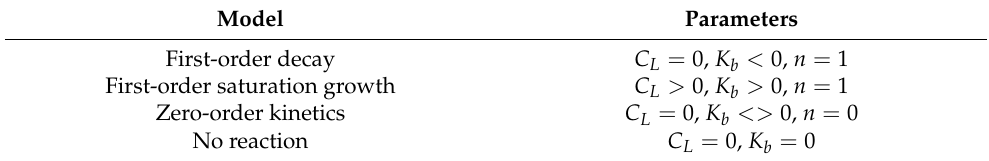
Table 1. Different kinetic models.